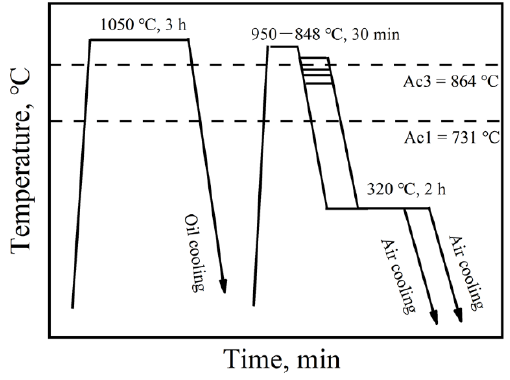
Figure 2. Schematic diagram of heat treatment process.